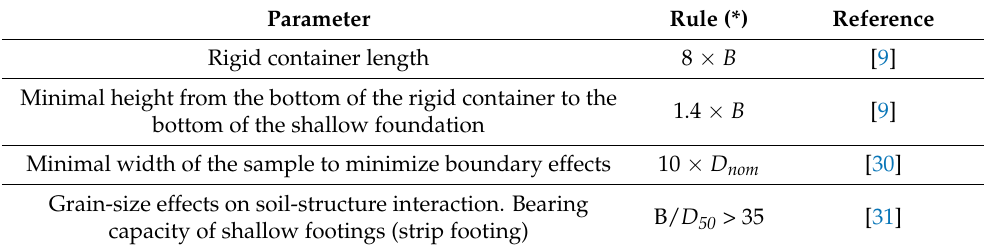
Table 4. Recommendations for experimental tests of shallow foundations in rigid containers.